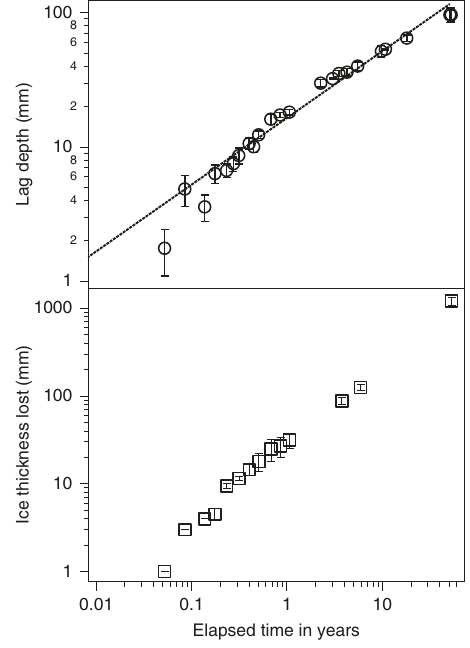
Fig. 4 The 52.5-year record of sublimation measurements from the tunnel. Upper panel: ice cemented loess yields a log normal relationship with an r 2 of 0.90. This fi t is denoted by the dashed line. Lower panel: loss of ice wedge ice over time. Vertical lines with horizontal bars represent plus and minus one standard deviation of the value for those